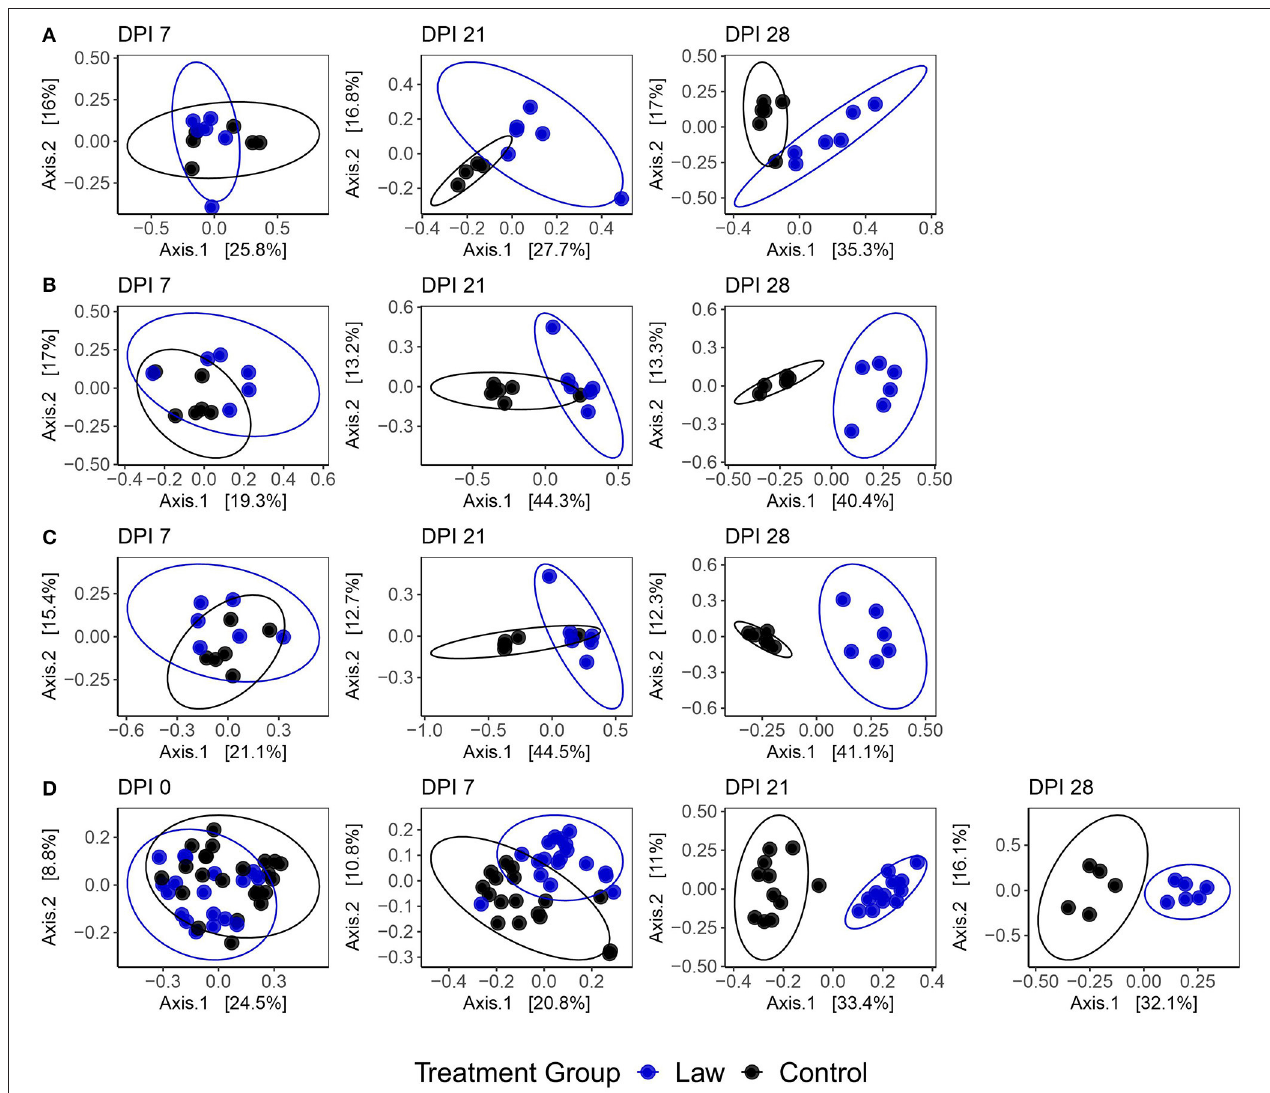
FIGURE 2 | Principal coordinate analysis plots using the Bray–Curtis dissimilarity of samples from (A) ileal mucosa; (B) ileal digesta; (C) cecal digesta; and (D) feces among Law and Control groups at different days post-infection (dpi). Ellipses represent the 95% confidence level of the multivariate Student’s t -distribution.